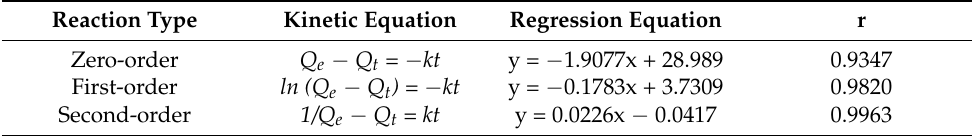
Table 8. Fitting results of the dissociation reaction kinetic curve at 298